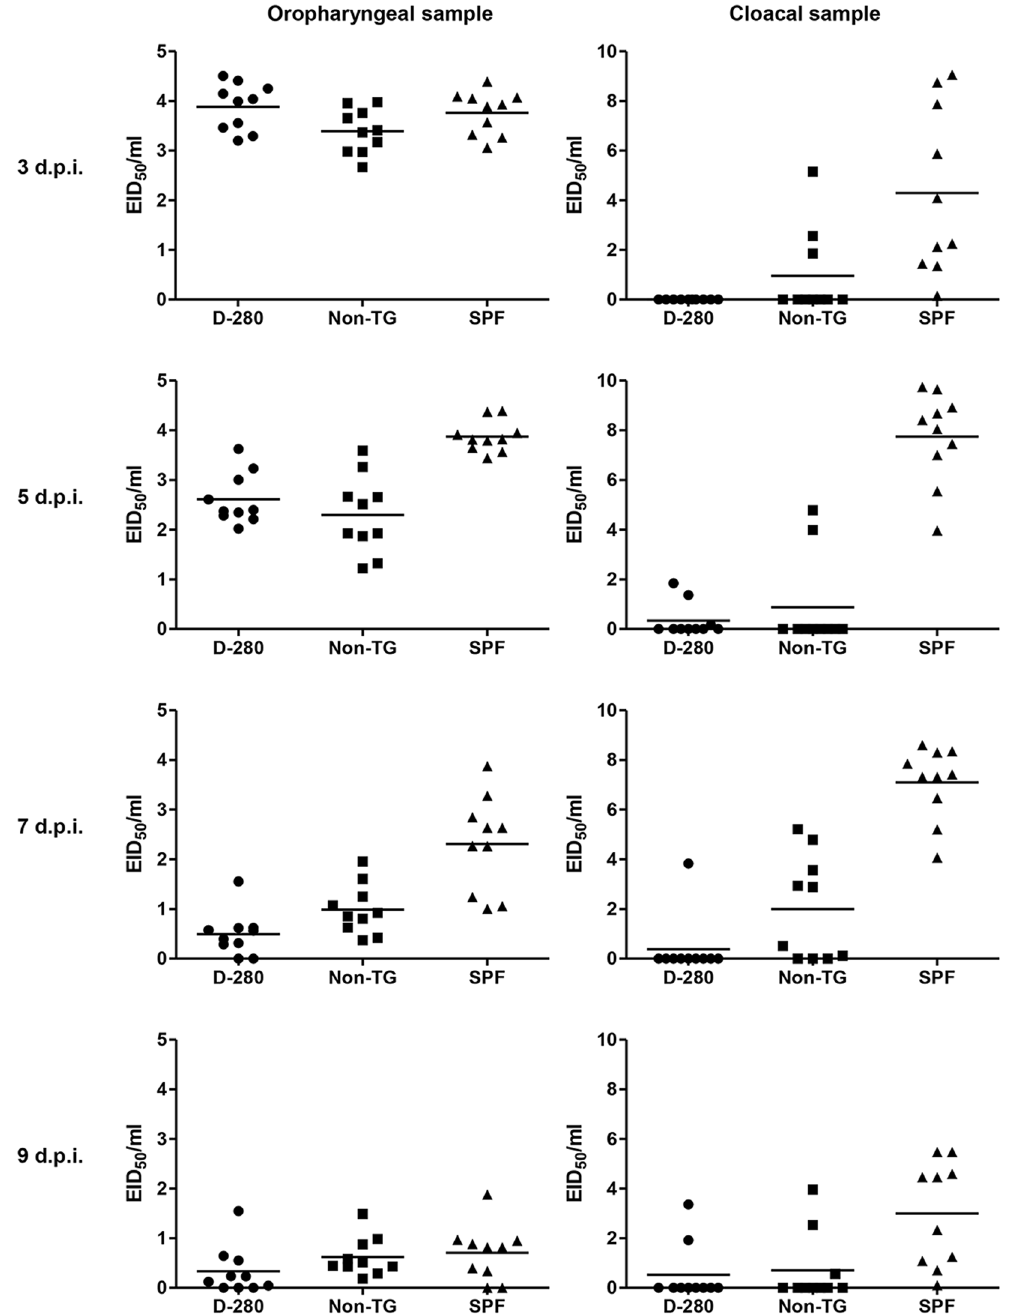
Figure 6. Viral shedding of directly challenged transgenic chickens. Twenty three-week-old non-transgenic chickens (non-TG) and transgenic chickens (D-280) were housed each containment cages in a BSL2 animal facility, and an additional twenty three-week-old SPF chickens were housed as a control group. Ten chickens from each group were intranasally challenged with 100 μ l of 10 7.5 EID 50 /mL H9N2 virus. The other 10 naïve chickens in each group were co-housed in the same containment isolator from 6 hour post-inoculation. Oropharyngeal and cloacal swab samples were collected at 3, 5, 7, and 9 days post-inoculation (dpi) from the challenged chickens and the viral RNA was quantified by real-time RT-PCR. Each cycle threshold value was extrapolated to egg infectious dose fifty and mean viral shedding titers were calculated. *** p < 0.001 by unpaired t